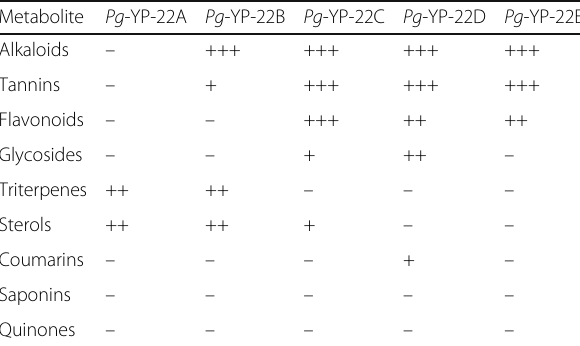
Table 2 Phytochemical screening of the P. guajava bark fractions